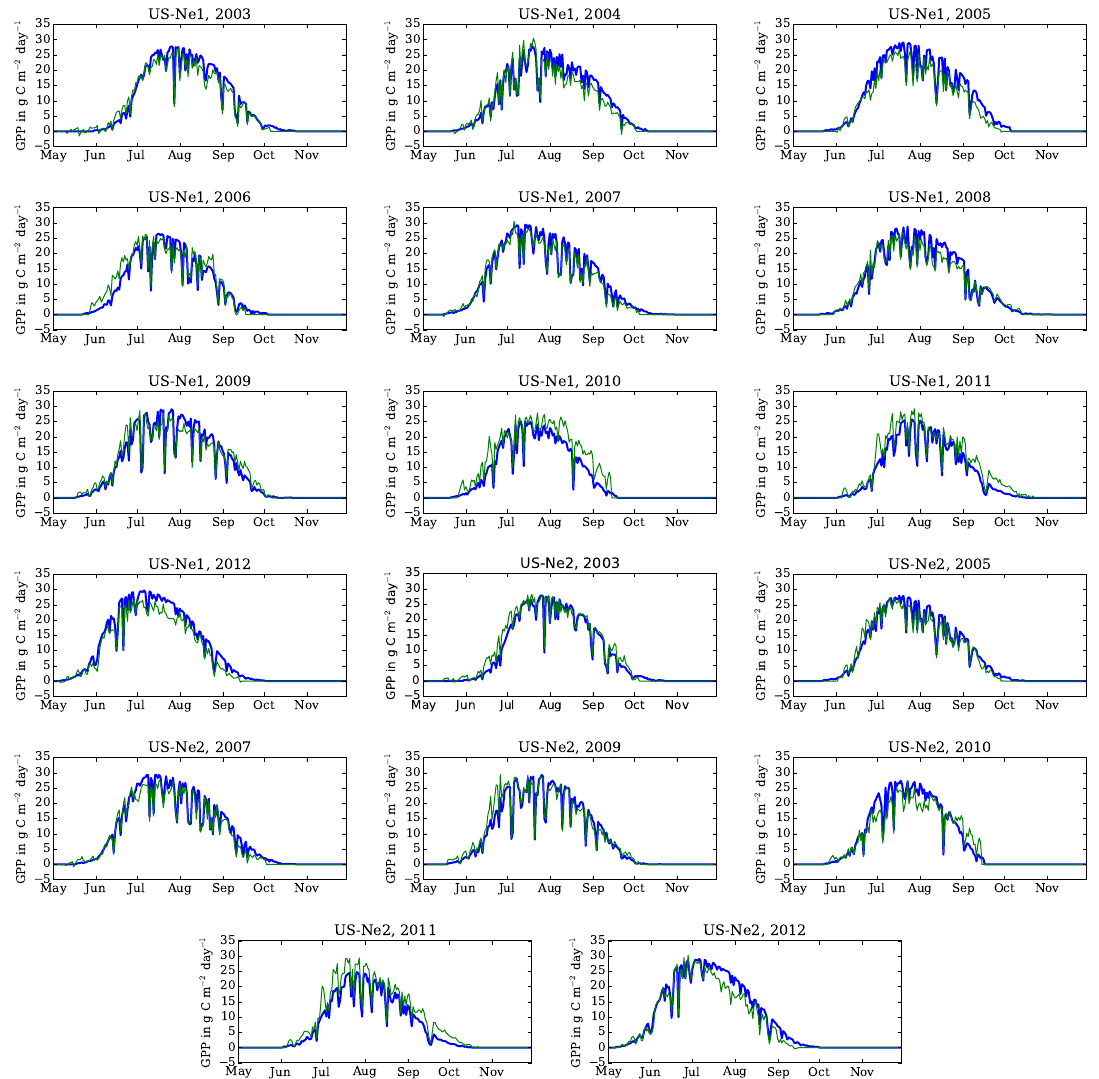
Figure 22. Time series of GPP for irrigated maize at the Mead FLUXNET sites US-Ne1 and US-Ne2; blue: model; green: observations. JULES runs have the crop model switched on and the input parameters in Tables 1, 2, 3, and 4.